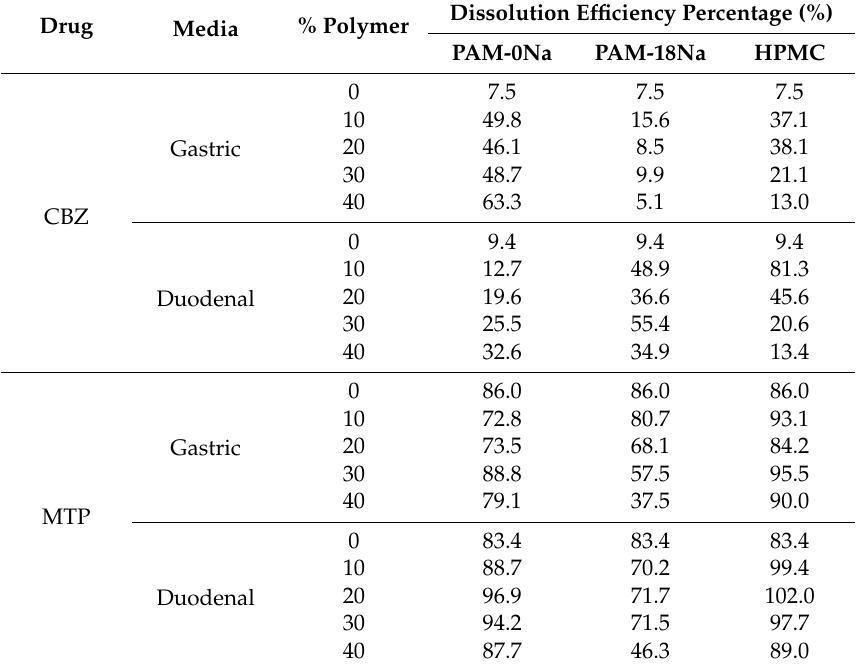
Figure 5. In vitro dissolution profiles of carbamazepine (CBZ) and metoprolol succinate (MTP) tablets elaborated with different polymer ratios: = 0%, = 10%, = 20%, =30% and = 40% and two media of physiological simulation. Table 3. Values of dissolution efficiency ( DE ) for CBZ and MTP tablets at different proportions of polymeric materials at 37°C, using two media of physiological simulation.